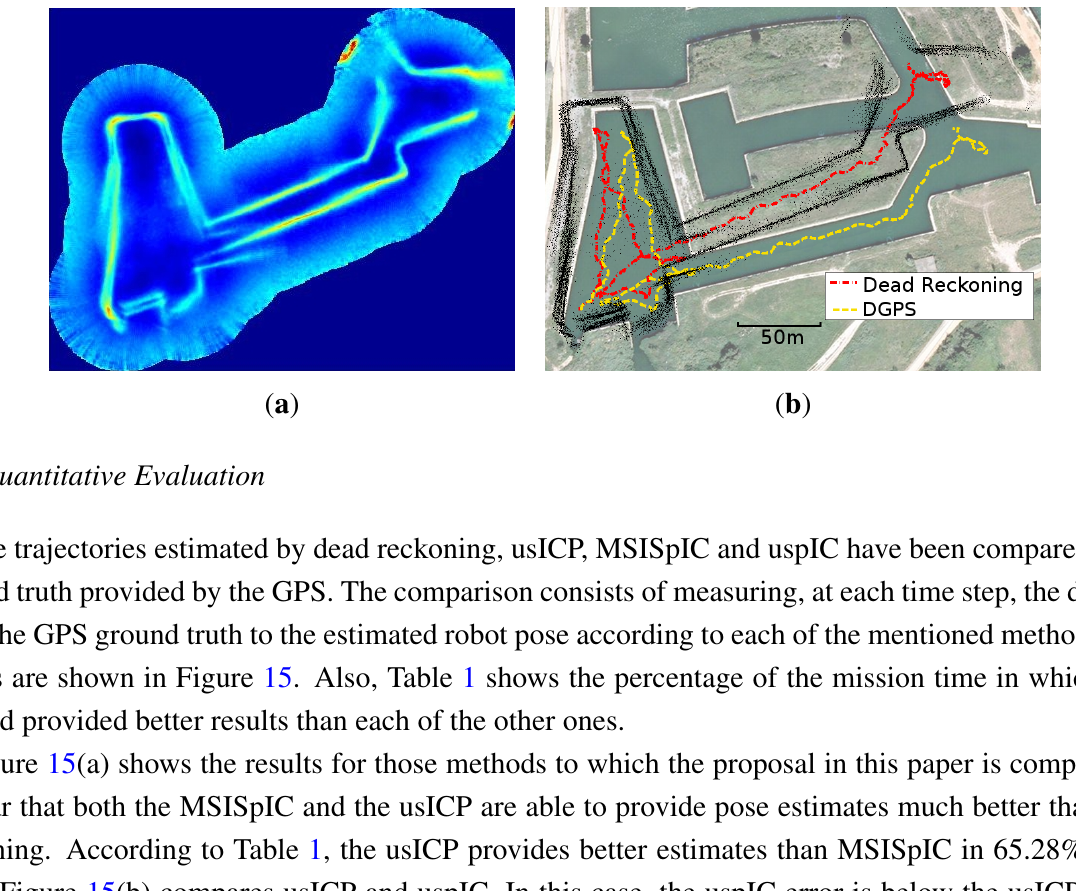
Figure 14. ( a ) The acoustic images drawn according to the dead reckoning; ( b ) Dead reckoning and GPS data overlaid to a satellite view of the environment.